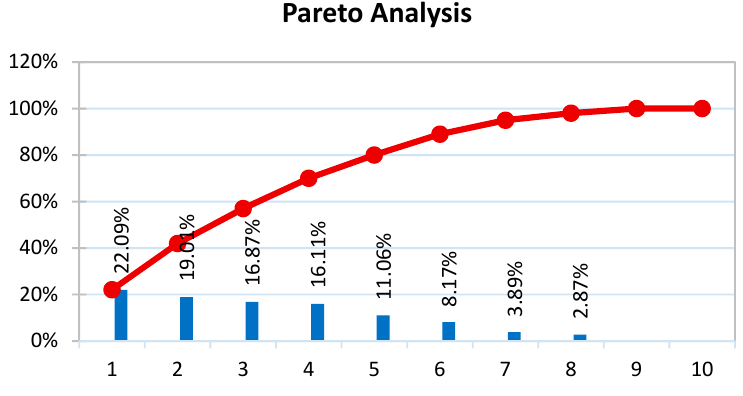
Figure 3. Pareto analysis of causes of stopping.